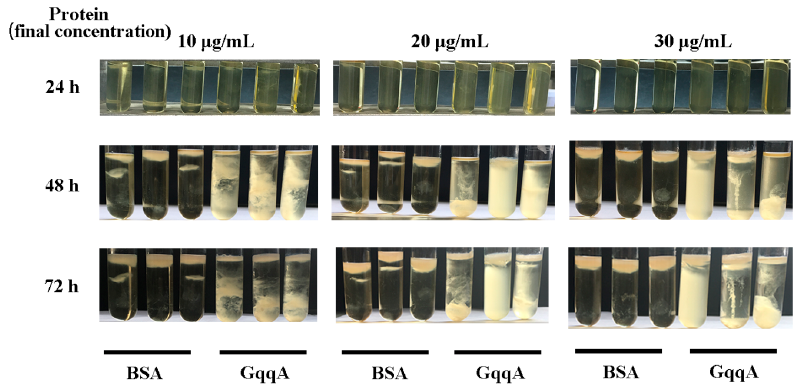
Figure 4. Bacterial cellulose (BC) production phenotypes of the strain G. xylinus CGMCC no. 2955 treated with three different concentrations (10, 20, and 30 μ g/mL) of the quorum-quenching protein (GqqA protein) and BSA as a control after 24, 48 and 72 h.